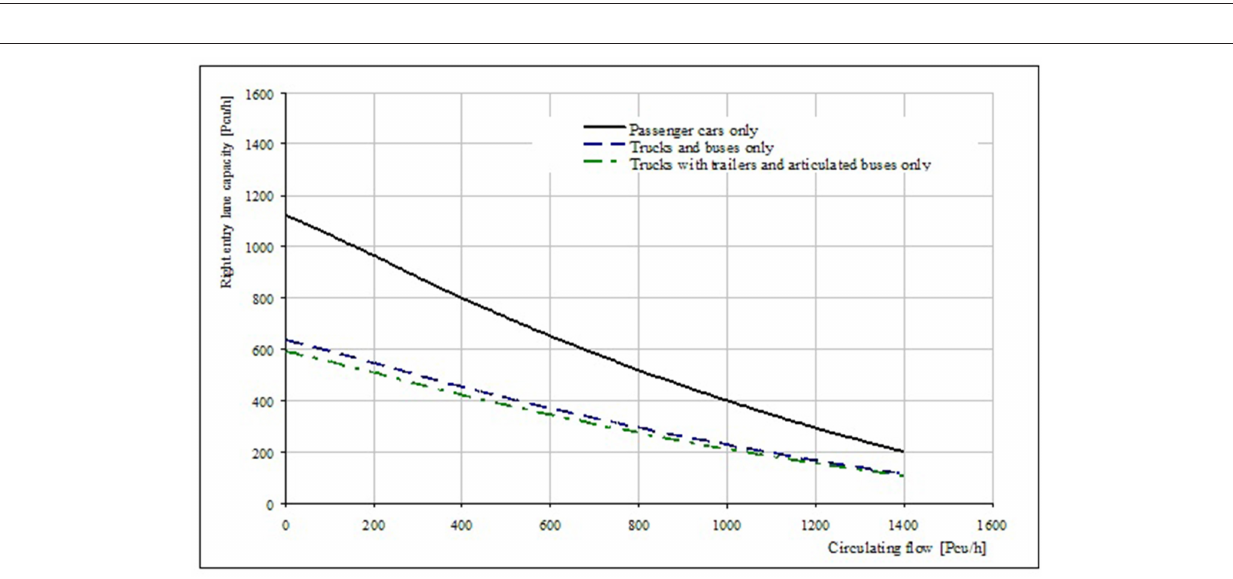
FIGURE 8 | Capacity of the right entry lane of the turbo roundabout for passenger cars only and heavy vehicles only.